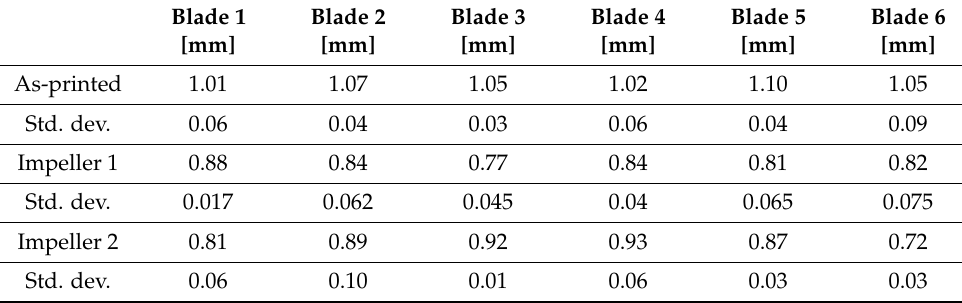
Table 5. Average blade thickness after AFM finishing process.